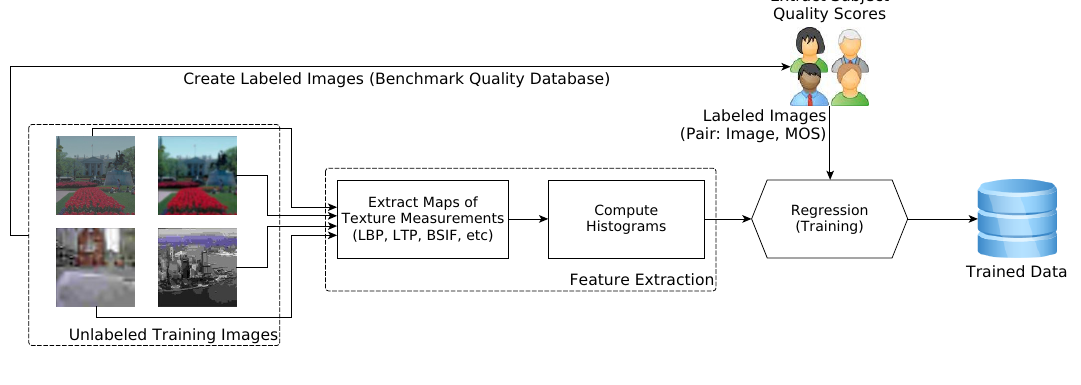
Figure 23. Training the quality